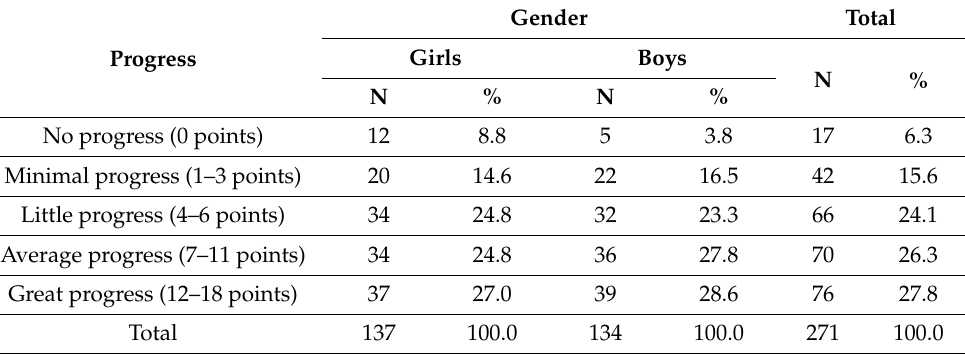
Table 1. Groups of progress in swimming for 10-year-old children based on skills expressed in points obtained in the final